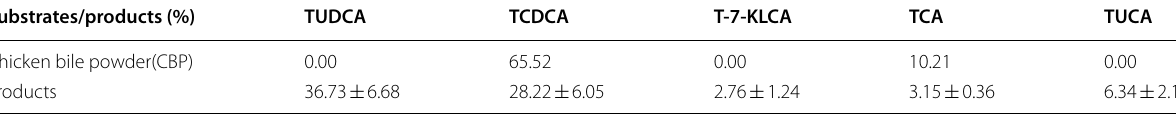
Table 4 Bile acids in the products Substrates/products (%) Chicken bile